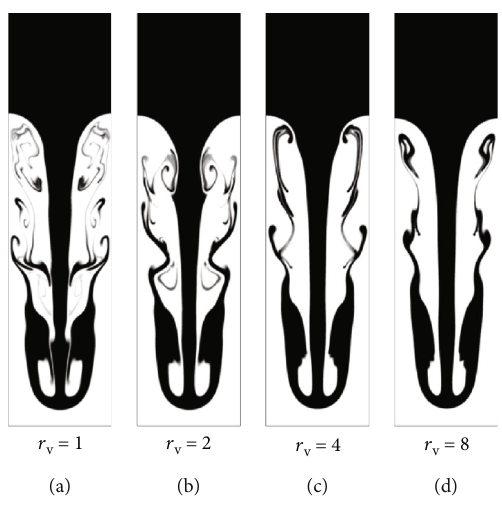
Figure 13: Snapshots of interface shape for di ff erent viscosity ratios ( Re = 2048 , At = 0 : 5 , and t ∗ = 5 : 0